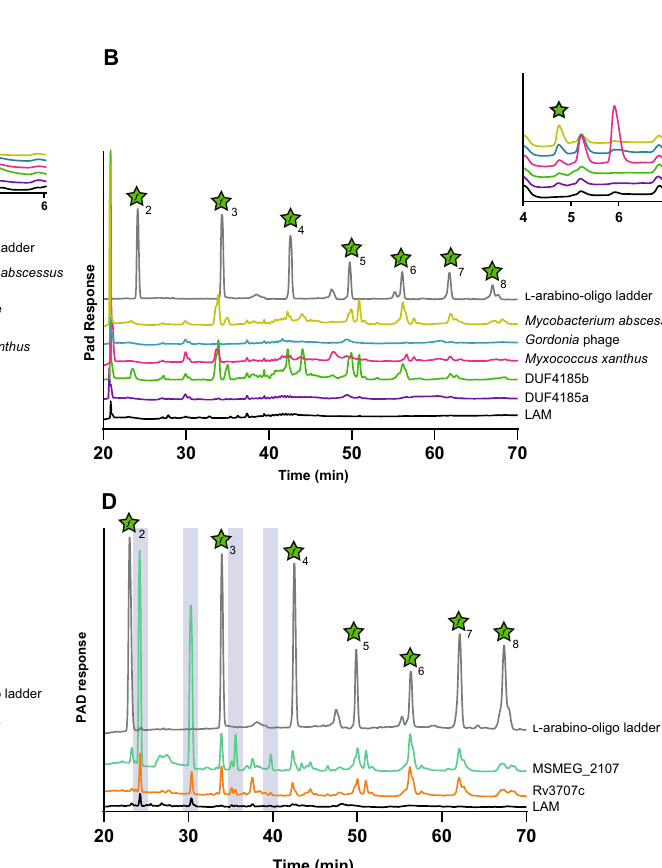
(25 µ M) derived from plant arabinan was used as a standard. In panel C the chro- matogramofthisladderhasbeenscaledonthe y -axisbyafactorof0.2forclarityof presentation. Source data are provided in the Source Data fi